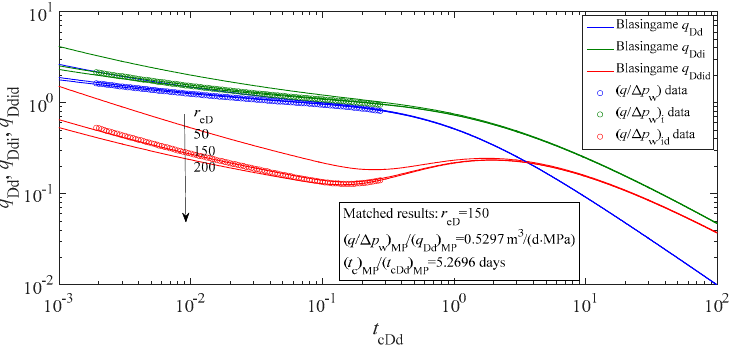
Figure 16. Match of production data for CRP case of